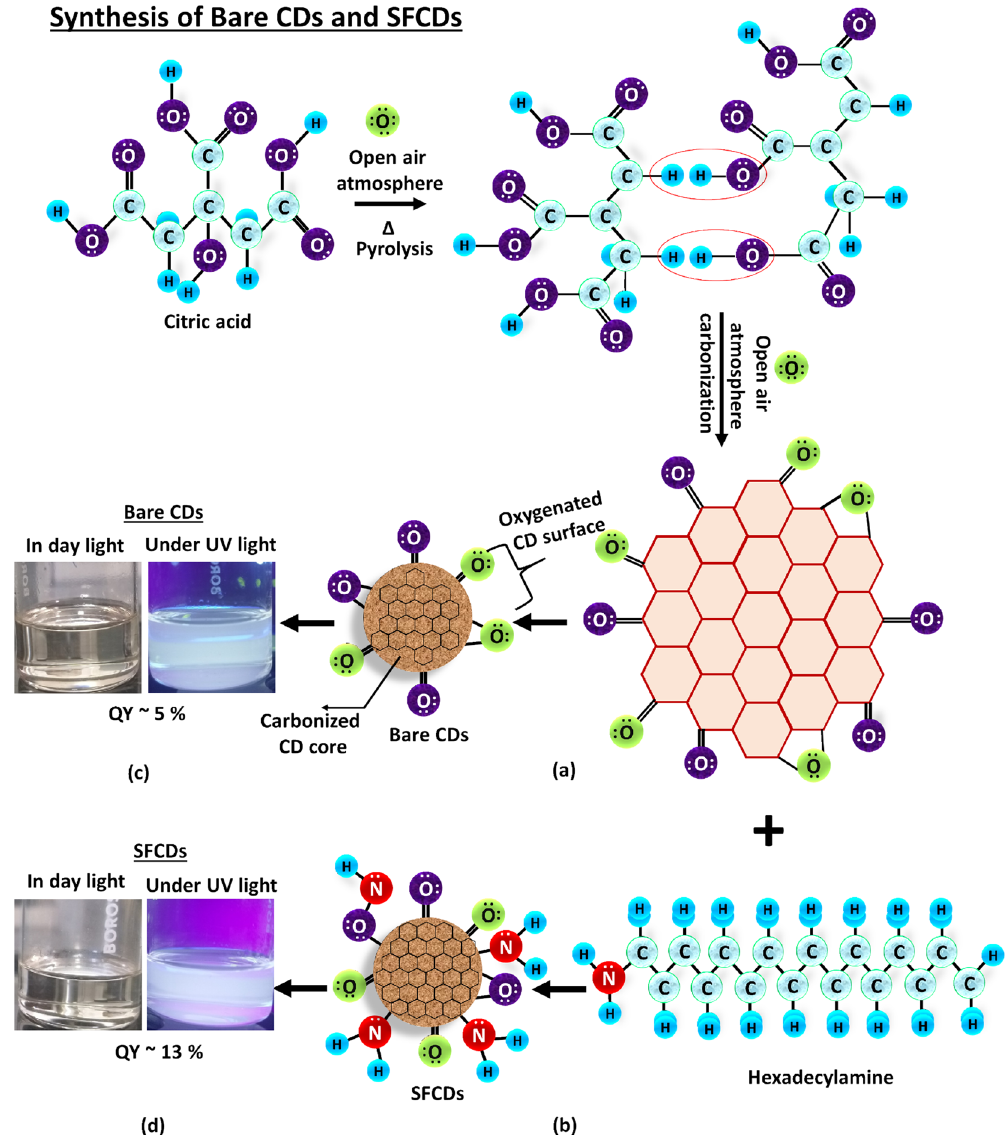
Figure 1. Schematic of synthesis of ( a ) bare CDs using citric acid as carbon precursor ( b ) SFCDs using citric acid as carbon precursor and hexadecylamine as surface functionalizing agent. Bare CD formation involves breakdown of citric acid molecules at higher temperatures accompanied by carbonization of carbon core. SFCDs precipitation involve breakdown of citric acid molecules at high temperatures (250 °C) accompanied by carbonization of carbon core followed by surface functionalization of CD surface with −NH 2 groups from hexadecylamine. Open air atmosphere synthesis of CDs and SFCDs favour oxygenation of CD surface that involve oxygen containing groups getting attached to CD (and SFCDs) (such as C=O, C− O) surface which further act as emissive trap sites. These emissive sites excite at different energies enhancing the emission bandwidth of CDs (and SFCDs) which exhibit bright white light emission under UV illumination. ( c ) CDs and ( d ) SFCDs show white light emission under UV